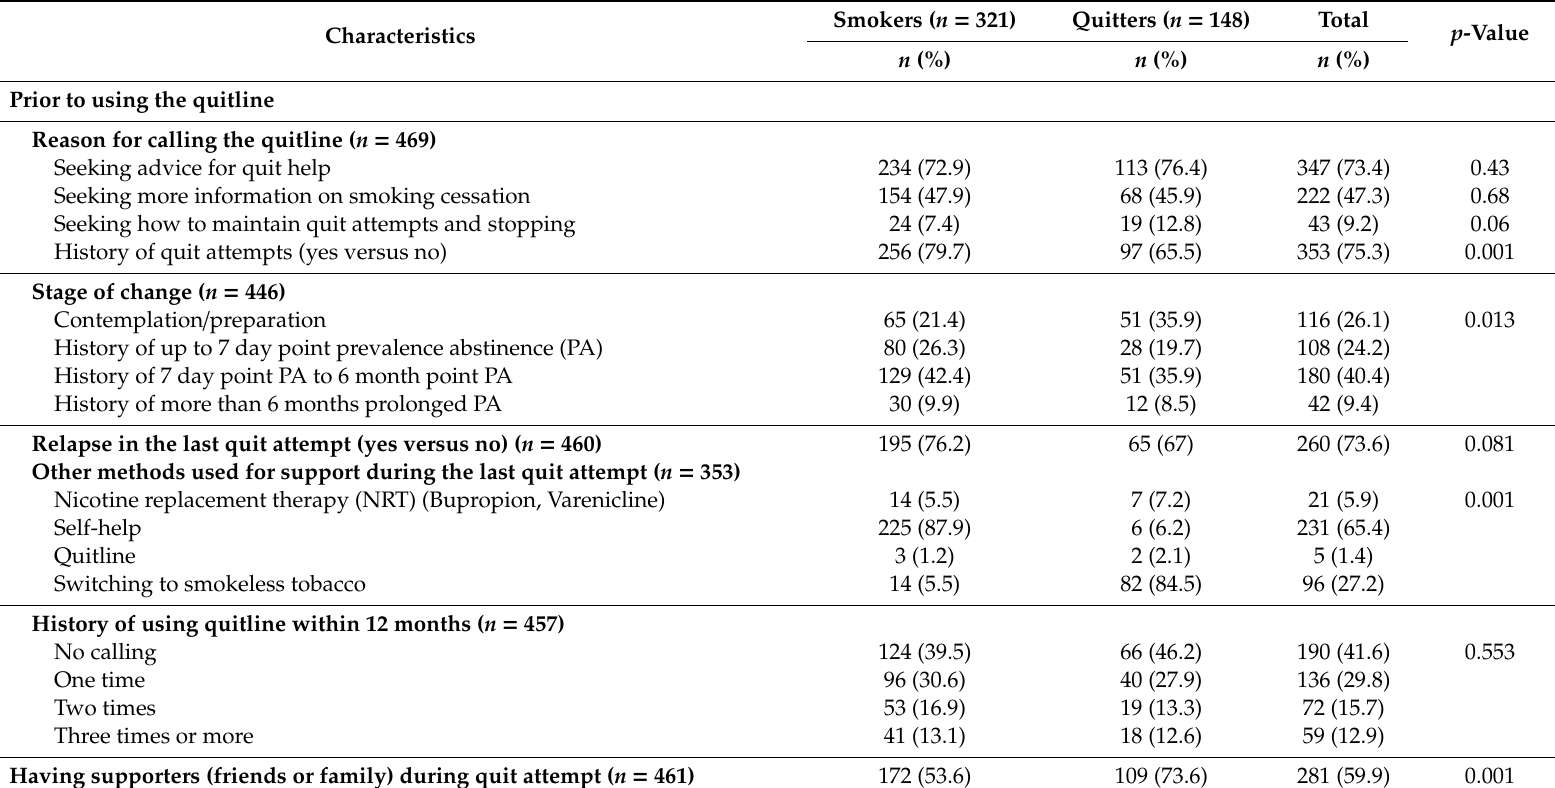
Table 2. Smoking patterns by smoking status ( n =